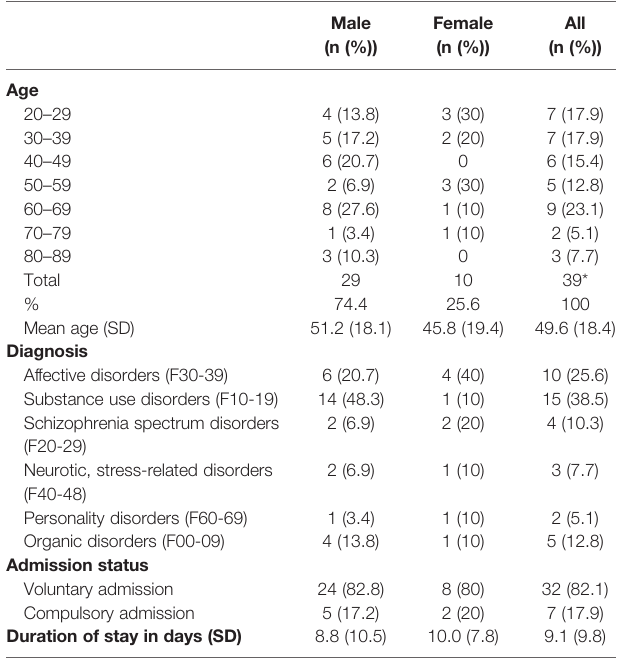
TABLE 3 | Characteristics of patients who died during the 5 years after discharge from an acute psychiatric department.